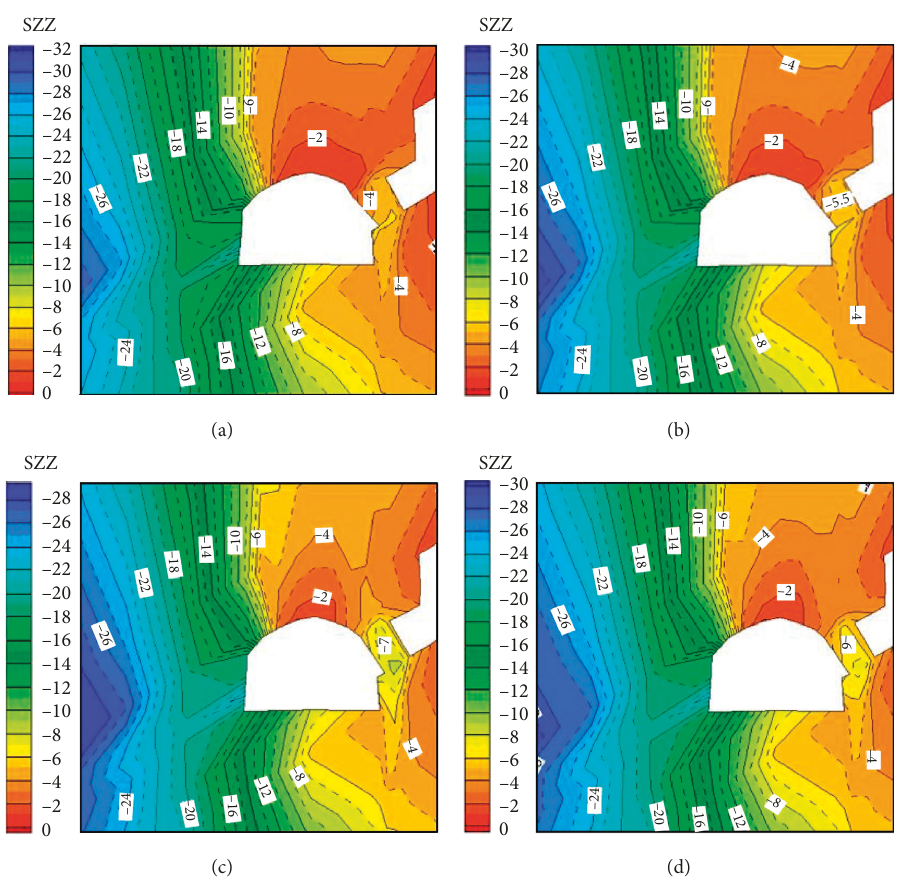
Figure 21: Vertical stress distributions of different concrete materials: (a) C40, (b) C50, (c) C60, and (d)